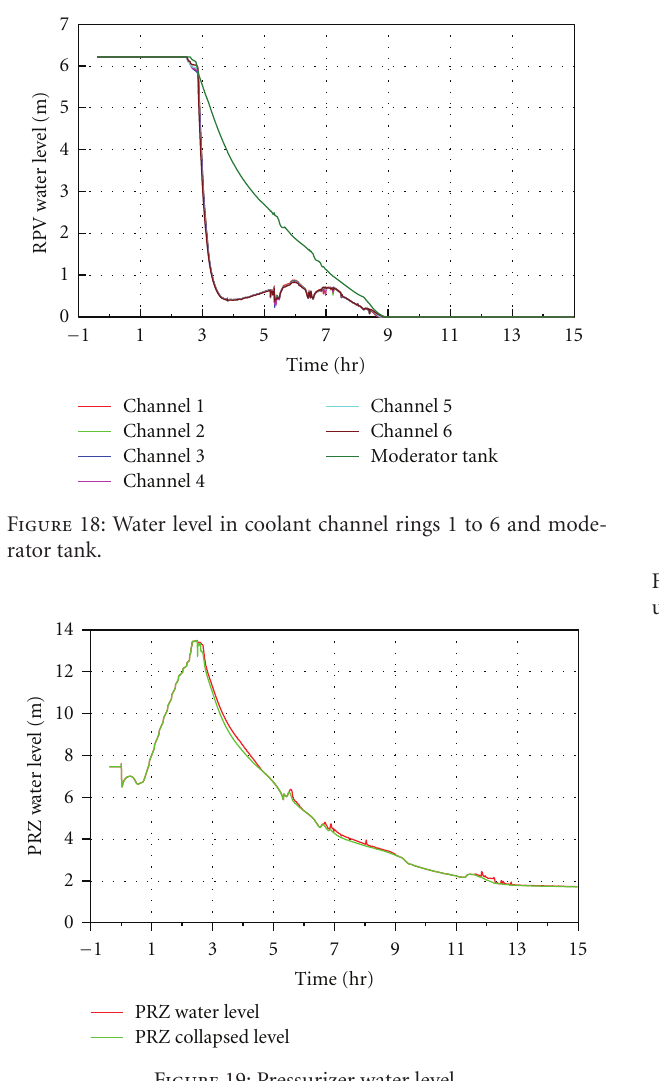
Figure 19: Pressurizer water level.